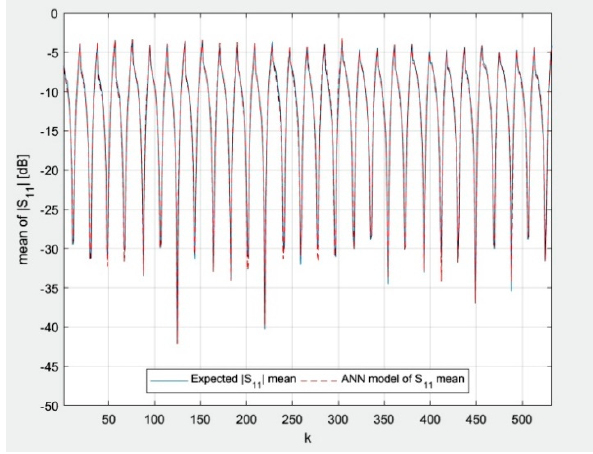
Figure 14. The expected and modeled mean of | S 11 | of an ordinary patch antenna in the range of the training data; k is the consecutive input data no. that follows the rule indicated in (1).